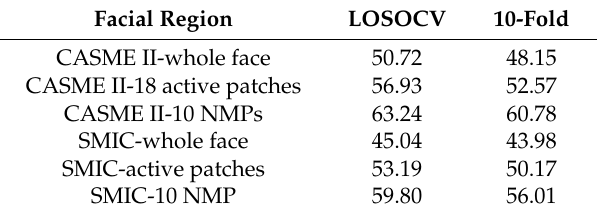
Table 7. Recognition rate in different regions of micro expression images in the CASME II database (%).